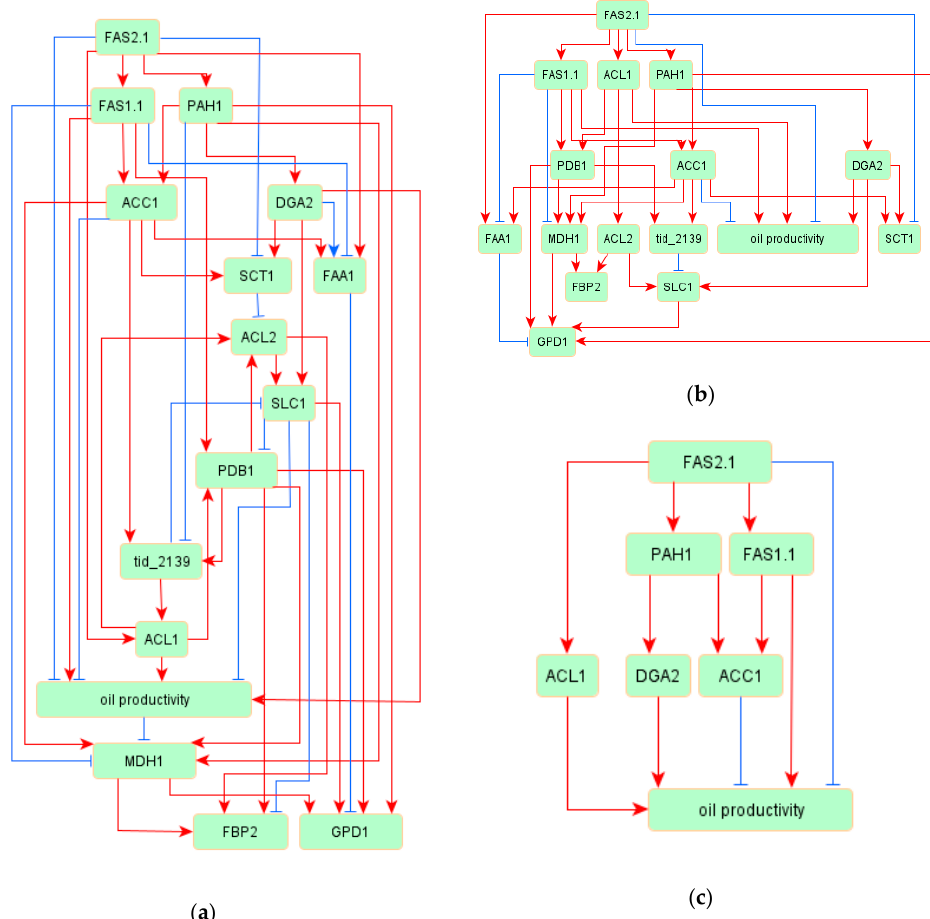
Figure 1. The inferred network model within the oil productivity group. Red arrows indicate positive regulations between variables, and blue arrows indicate negative regulations: ( a ) the whole inferred network model; ( b ) the extracted network model with strong regulation from the whole inferred mode; and ( c ) the regulatory model for oil productivity.